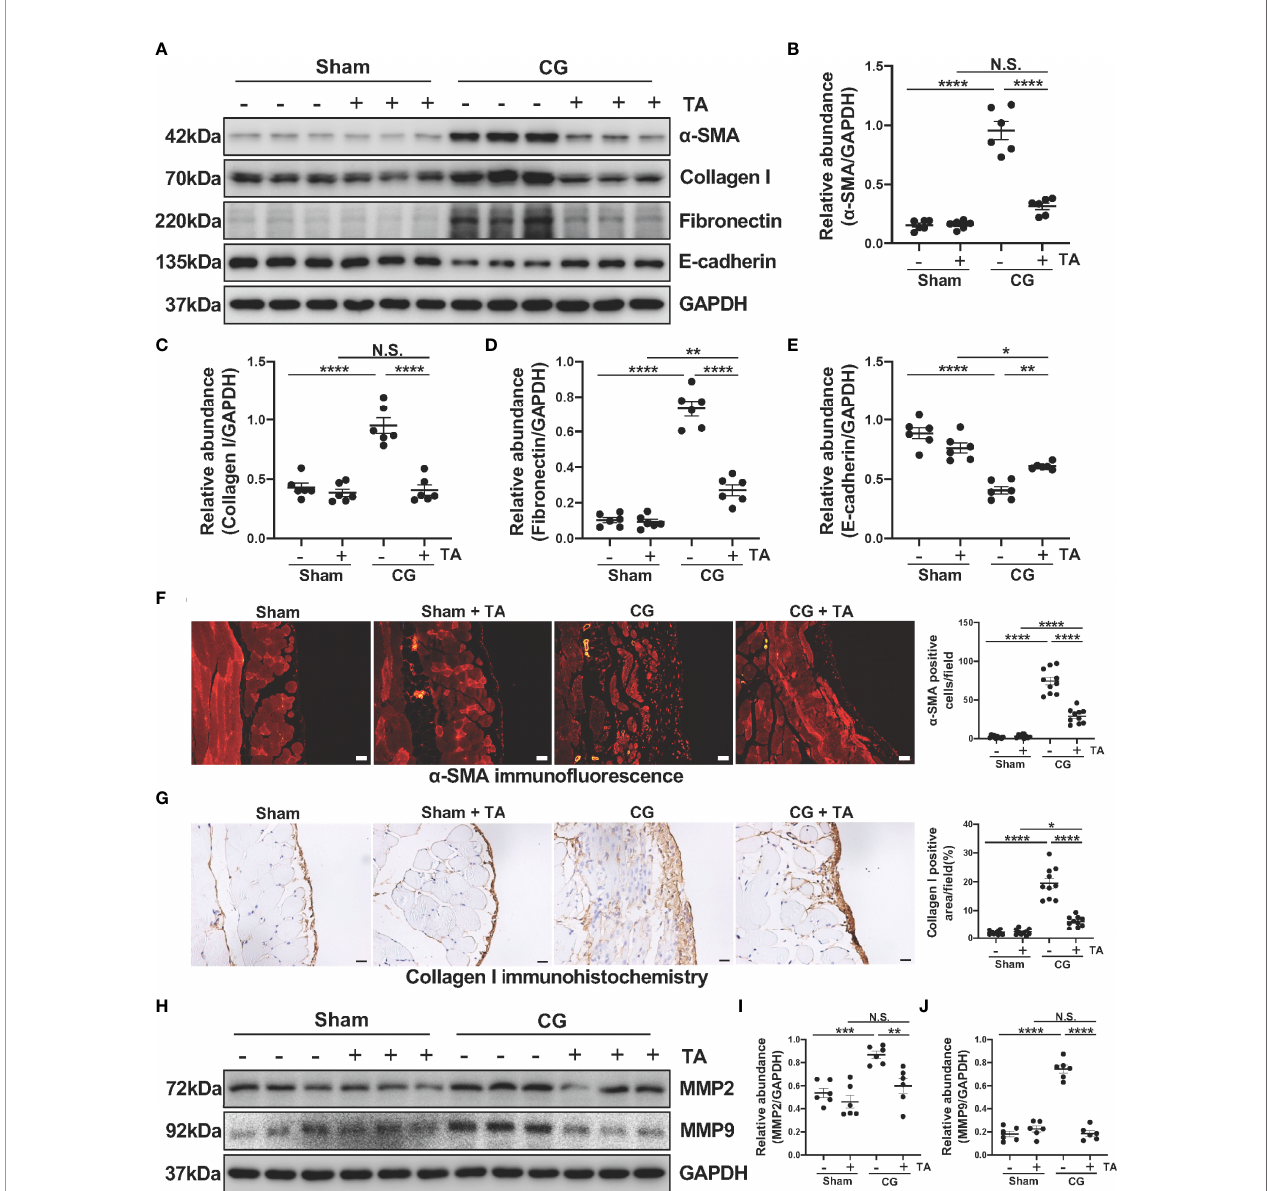
FIGURE 2 | TA inhibits CG-induced EMT and ECM protein deposition in the fi brotic peritoneum. (A) Western blot analysis showed the protein levels of a -SMA, Collagen I, Fibronectin, E-cadherin, and GAPDH in peritoneum from different groups of mice. Expression levels of (B) a -SMA, (C) Collagen I, (D) Fibronectin, and (E) E-cadherin in different groups were quanti fi ed by densitometry and normalized with GAPDH. (F) Representative micrographs of immuno fl uorescence staining of a -SMA and quantization count of a -SMA-positive cells. (G) Representative micrographs of immunohistochemical staining of Collagen I and quantization of Collagen I-positive area (%). (H) Western blot analysis showed the protein levels of MMP2, MMP9, and GAPDH in peritoneum from different groups of mice. Expression levels of (I) MMP2 and (J) MMP9 in different groups were quanti fi ed by densitometry and normalized with GAPDH. Data were expressed as means ± SEM. *P<0.05, **P<0.01, ***P<0.001, ****P<0.0001. All scale bars = 20 m m. NS: P ≥